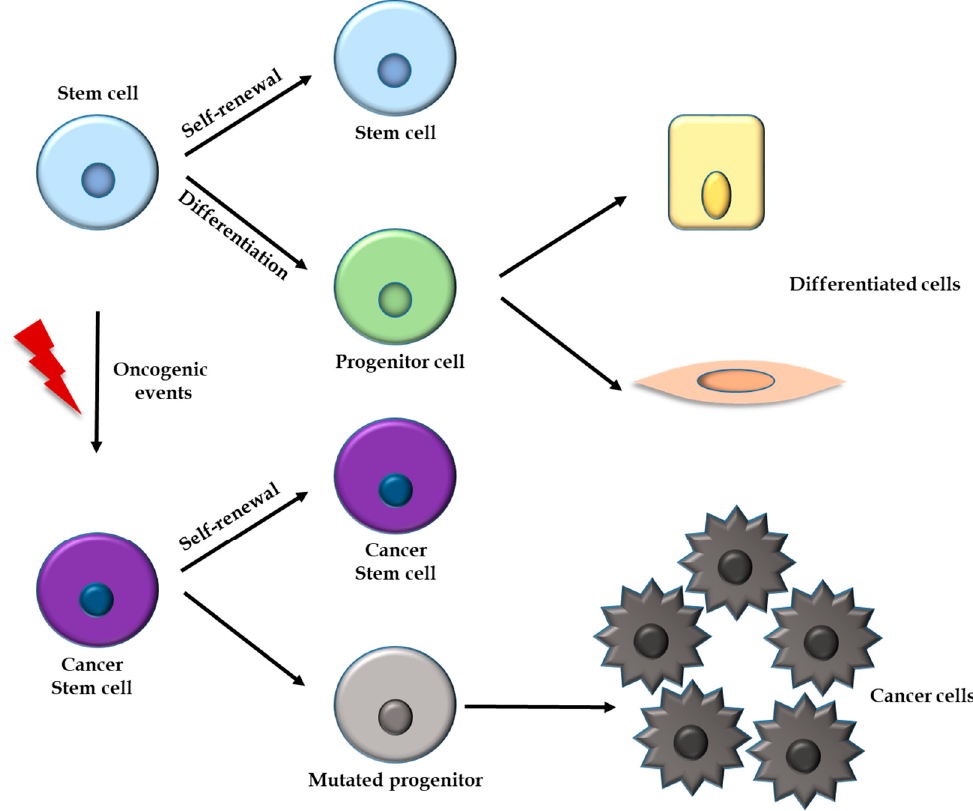
Figure 2. Stem cells are capable of generating more cells of the same type by self-renewal and progenitor cells by differen- tiation, which, in turn, originate several types of differentiated cells. Cancer stem cells (CSCs) are generated from normal stem cells after epigenetic mutations occur. Oncogenic events include the activation of proto-oncogenes in addition to the inactivation of tumor suppressor genes and DNA repair mechanisms. CSCs are capable of self-renewal and generating daughter cells (mutated progenitors) that have more limited self-renewal ability and can originate cancer cells.